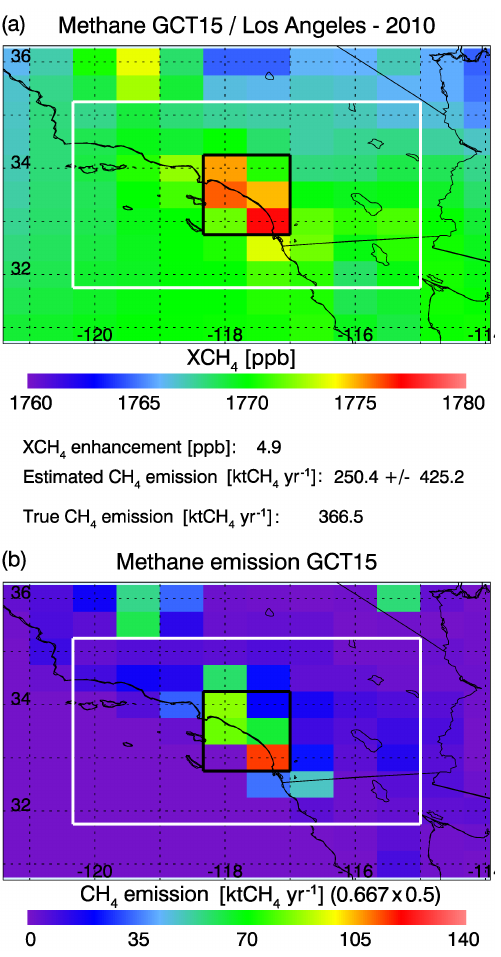
Figure 11. As Fig. 9 but for the region around Los Angeles, Califor- nia (this region is located in the southern part of the source region shown in Fig.